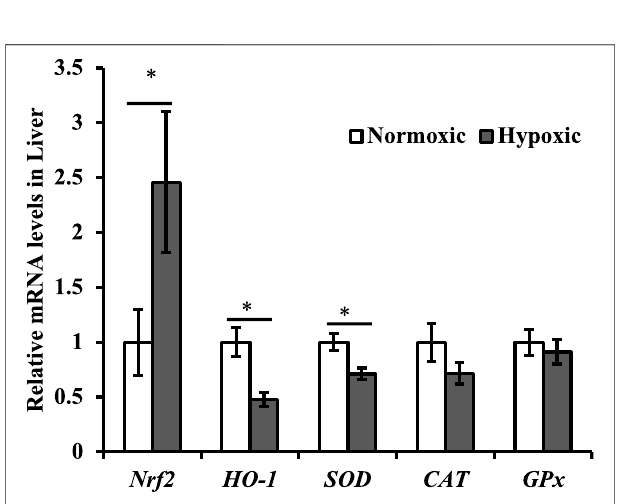
FIGURE 4 | Effect of acute hypoxic stress on the expression of the immune-related genes in the liver of triploid rainbow trout ( n = 6; IFN- γ , interferon γ ; TNF- α , tumor necrosis factor- α ; HSP-70, heat shock protein 70; IL-1 β , interleukin-1 β ; IL-8, interleukin-8). Asterisks indicate signi fi cant differences ( t -test; * p < 0.05; ** p <